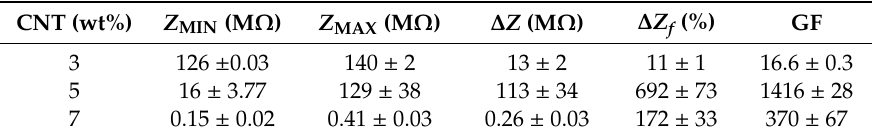
Figure 13: a) fractional change in electrical impedance (  Z f ) as a function of strain and b) Gauge Factor (GF) at fixed strains (i.e. 0.15, 0.20 and 0.40%, respectively) for PP/CNT ‐ 5 and PP/CNT ‐ 7 nanocomposites.